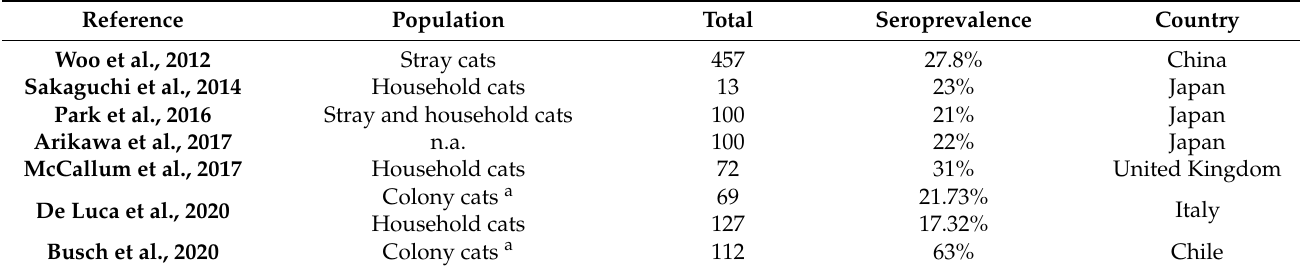
Table 2. Reported FeMV seroprevalence of cats in relation to population sampled and